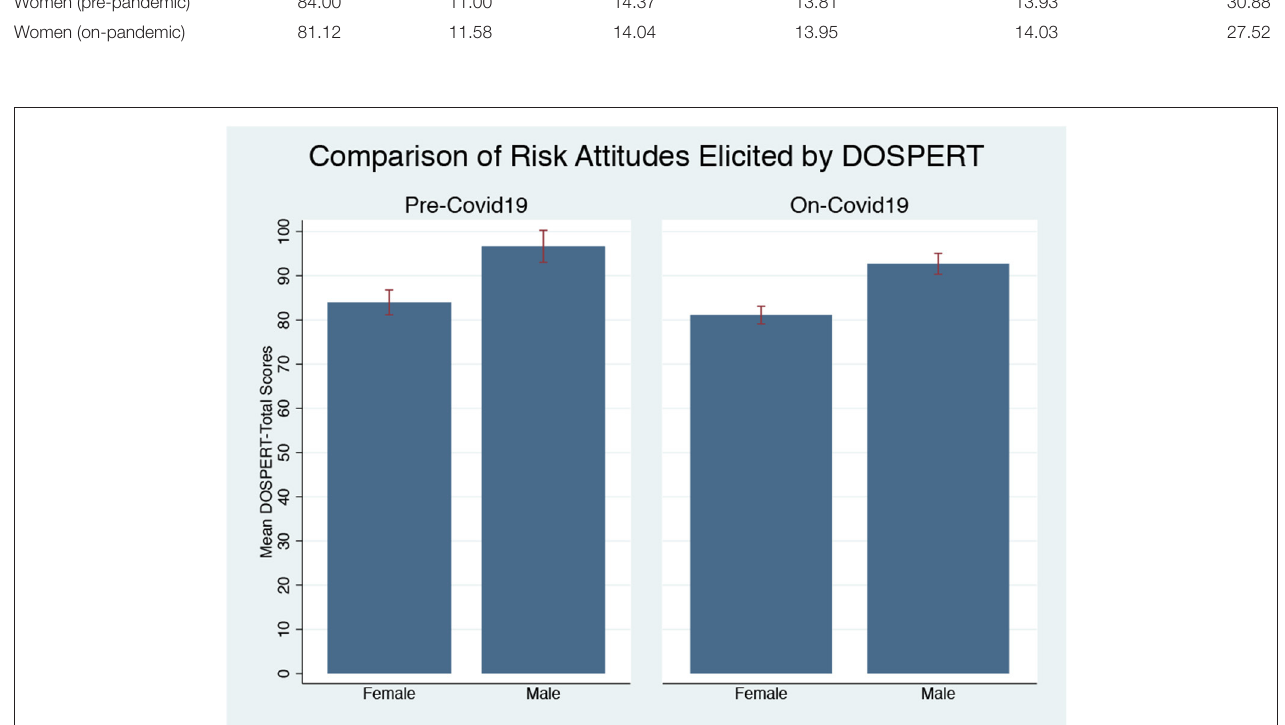
FIGURE 5 | Gender differences in risk-taking by DOSPERT pre and on-pandemic.